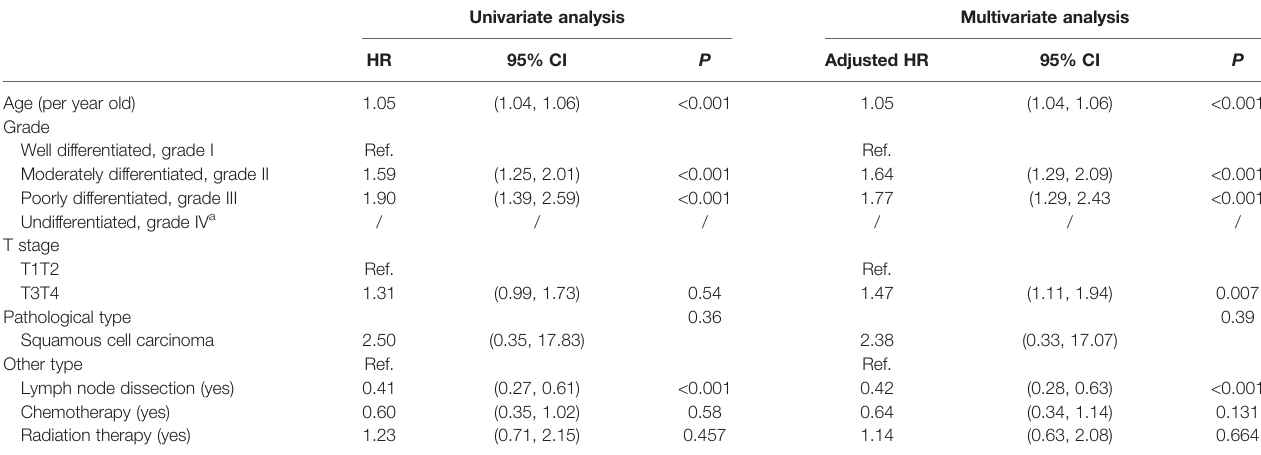
TABLE 2 | Univariate and multivariate Cox regression for overall